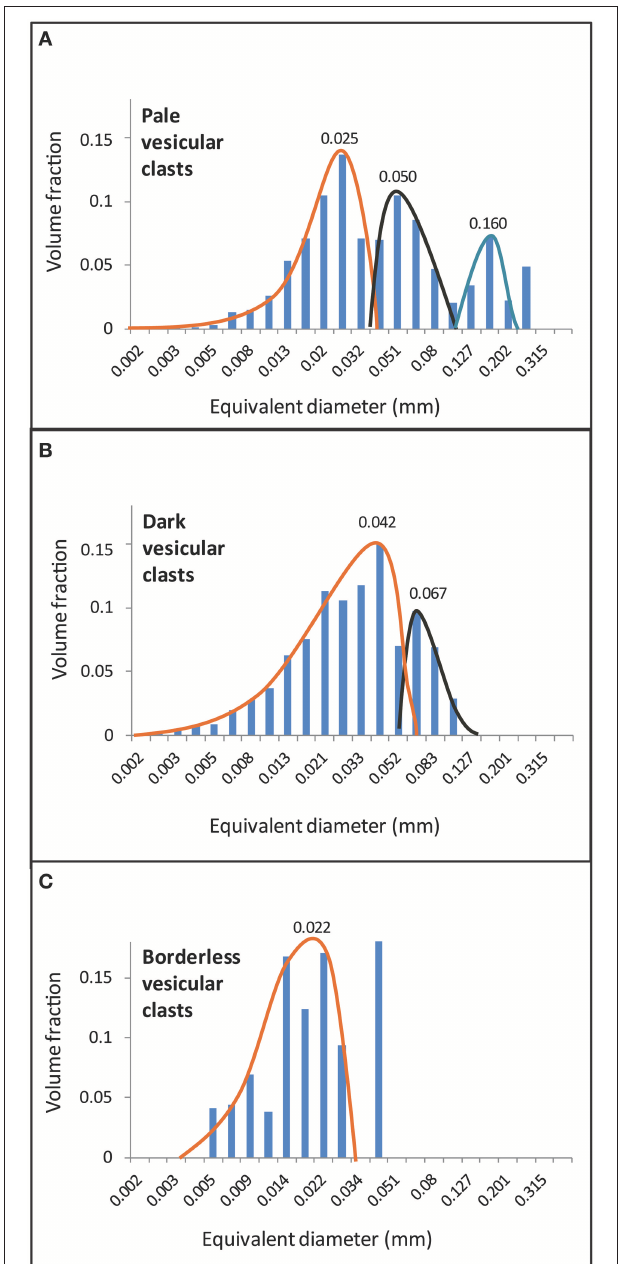
FIGURE 6 | Typical bubble size distributions for each vesicular clast type, as normalized volume fraction. (A) The pale clasts exhibit three distinct peaks centered at 0.025, 0.050, and 0.160mm, with each parabolic curve corresponding to a bubble subpopulation and a discrete vesiculation event. The last isolated peak on the right results from coalescence. (B) Dark clasts record two vesiculation events, whereas the borderless clasts (C) have evidence of one single vesiculation event with minor coalescence. The largest bubbles, corresponding to the blue curve in (A) , relate to the earliest vesiculation event. In all clasts, the negative skew of the orange curve indicates accelerating nucleation and growth in the last vesiculation event. The borderless clast distribution is less smooth because of a smaller total bubble population.